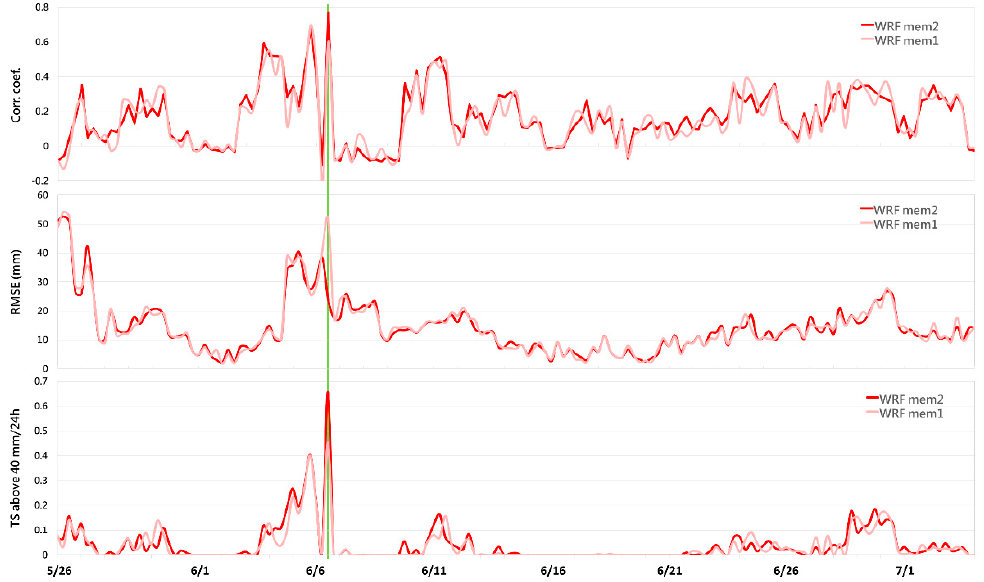
Figure 9. The (from top to bottom) correlation coefficient, root-mean-square error, and threat score above a 40-mm threshold of the predicted 24–48-h rainfall for the 152 rainfall forecasts initialized during 00:00 UTC 26 May–18:00 UTC 2 July 2020, for WRF Members 1 (pink curves) and 2 (red curves). The green line denotes the forecast initialized at 12:00 UTC 6 June 2020.